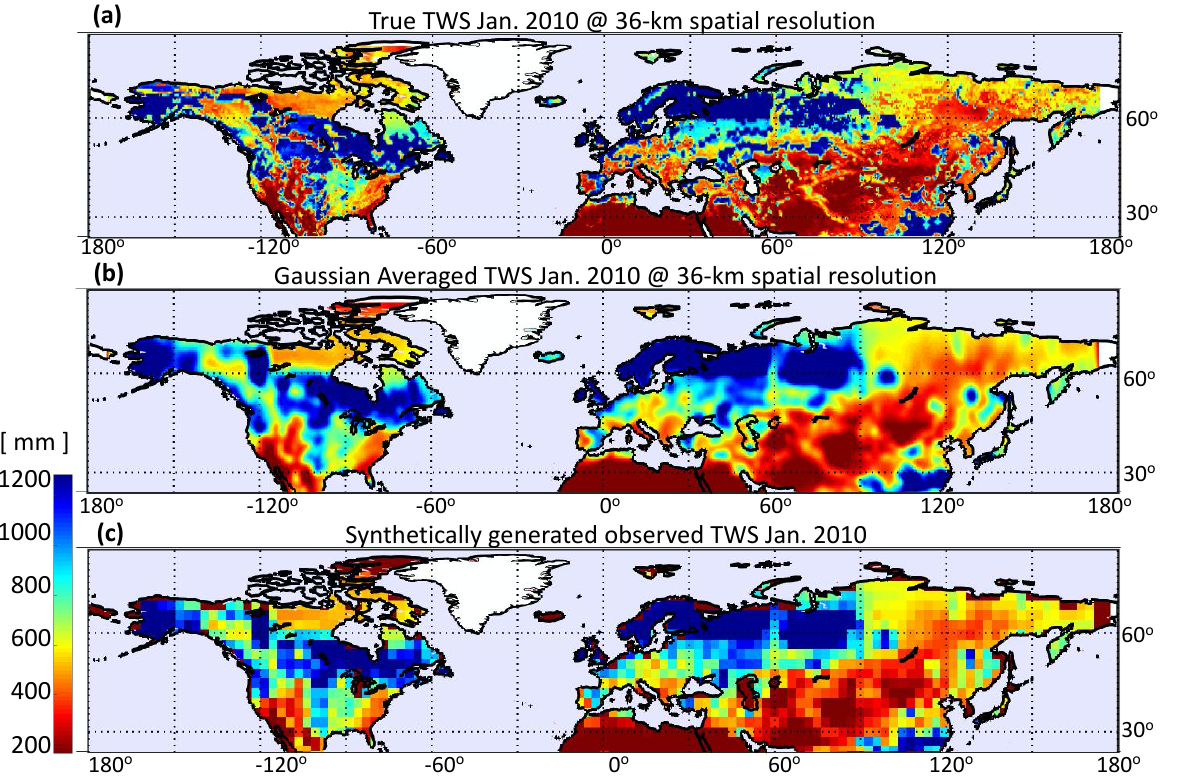
Figure 2. ( a ) Synthetic Terrestrial Water Storage (TWS) at the model 36-km spatial resolution for a sample month (Jan 2010); ( b ) As in ( a ) but after applying a 300-km Gaussian smoothing function; ( c ) Synthetically generated TWS obtained from sub-sampling ( b ) at 3 × 3 degree spacing. Panels ( a – c ) illustrate the process used to generate the synthetic, GRACE-like TWS